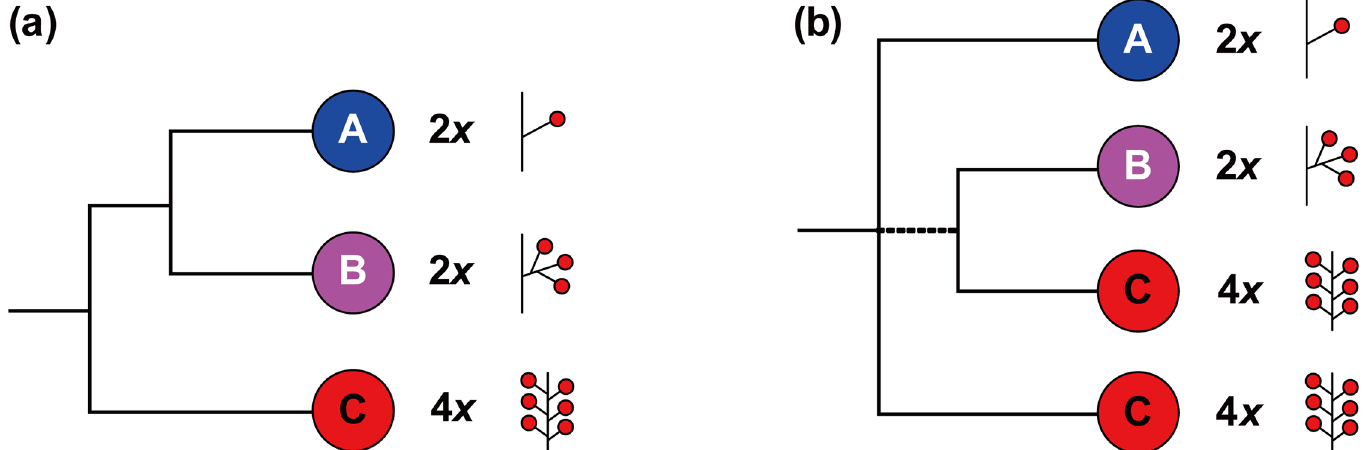
Fig 1. Summary of phylogenetic relationships in Prunus , based on the plastid DNA data (a), and nuclear sequences (b) (simplified from Chin et al. [4]). A = solitary inflorescence clade, including subgenus Prunus and Amygdalus ; B = corymbose inflorescence clade, which refers to subgenus Cerasus ; C = racemose inflorescence group, including subgenus Laurocerasus , Padus , Maddenia and Pygeum group.